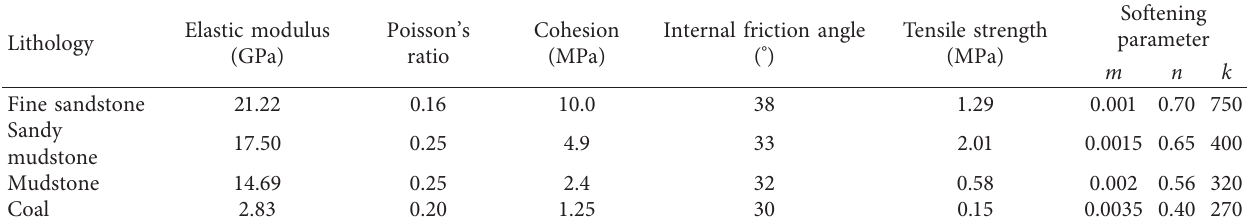
Table 1: Rock parameters.